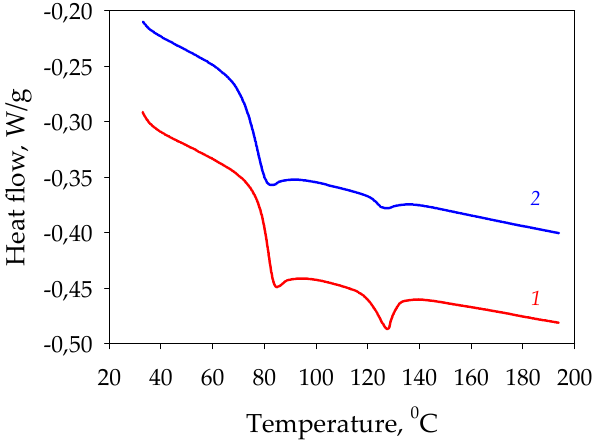
Figure 7. DSC of PETG—ethyl acetate: 1 —sample in equilibrium desorption state, 2 —initial sample.